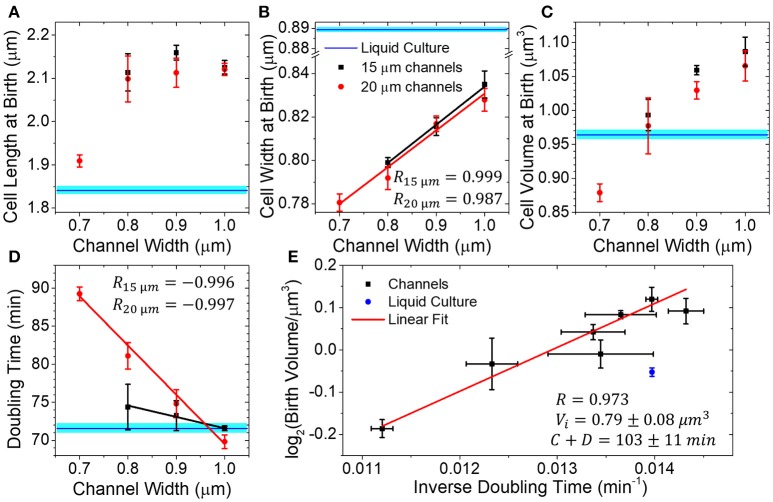
Dimensions of the mother cell and its doubling times in dead-end channels of different widths. (A–D) Mother cell length, width, volume and doubling time as a function of channel width in channels of 15 (red circles) and 20 μm (black squares) length. All measurements have been done at 28°C. Data points represent the average of three independent measurements. In each measurement, more than 300 cell births have been analyzed. Error bars are s.e.m. of the three independent measurements. Blue horizontal lines represent measurements of cells from liquid culture tubes. The width of these lines corresponds to s.e.m. All other solid lines are linear fits to the data. (E) Logarithm of birth volume, Vb, as a function inverse of doubling time, Td-1. Solid line shows the fit of the data to the universal growth law, Vb=(12)Vi•2C+DTd. In the universal growth law, Vi is cell volume at the initiation of replication, C the time taken to replicate DNA and D the time taken from the end of replication to cell division. Here Vi and C+D are treated as fitting parameters with best fit values Vi=0.79±0.08 μm3 and C+D = 103±11 min. The errors are standard error.